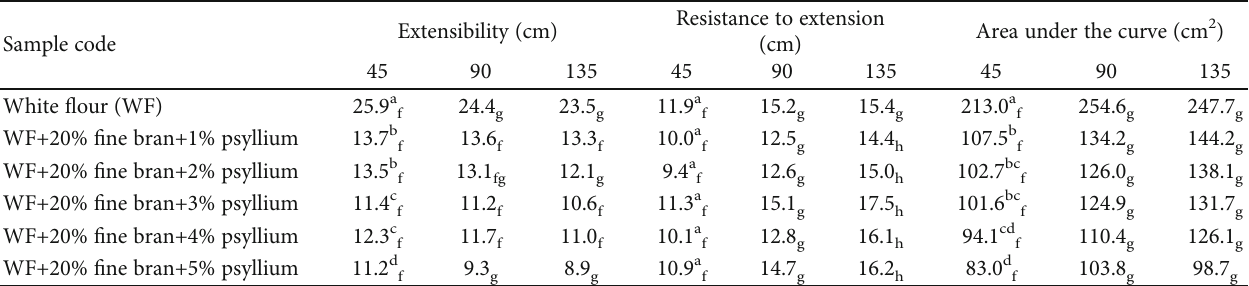
Table 10: Extensograph characteristics of dough made from fl our, fi ne bran, and psyllium blends.